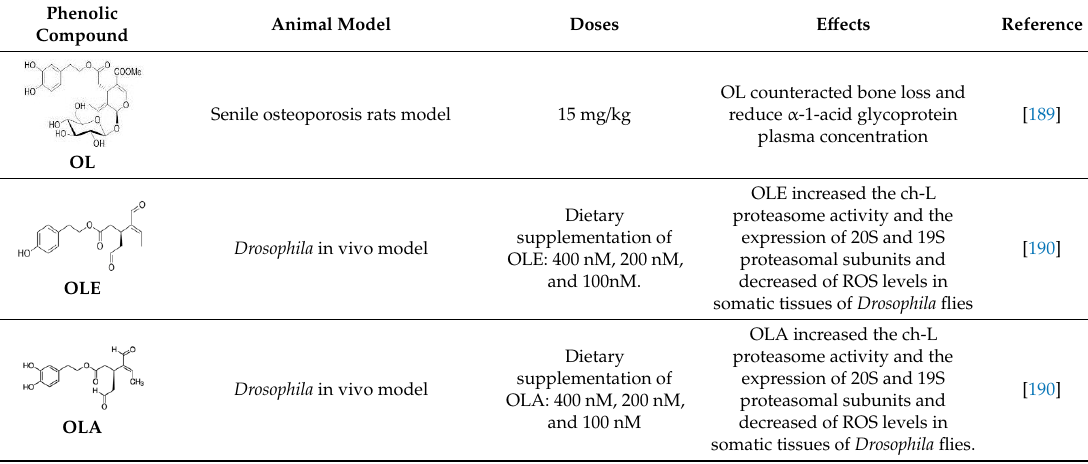
Table 8. Potential role of secoiridoids obtained from the olive tree in anti-aging processes: in vivo studies.